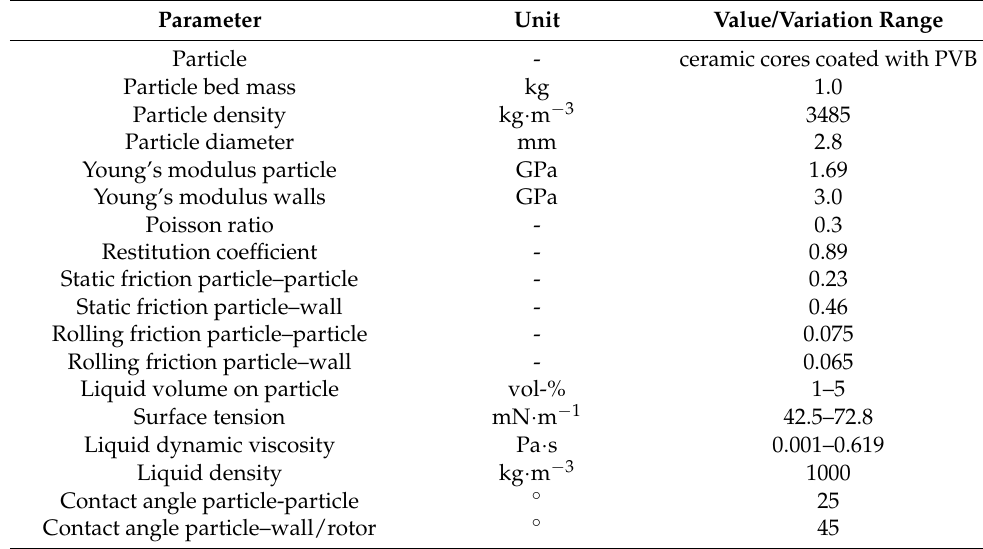
Table 2. Material properties for the DEM simulation.